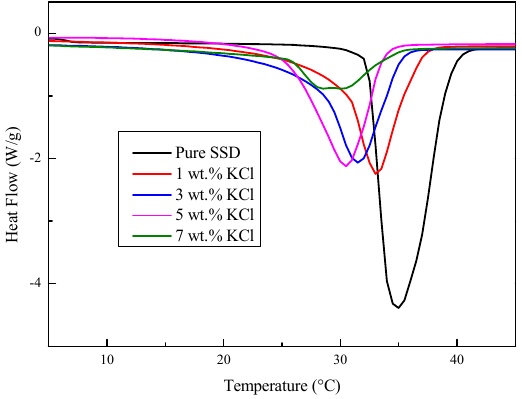
Figure 1. DSC curves of the Na 2 SO 4 · 10H 2 O–KCl eutectic mixtures with varying contents of KCl.